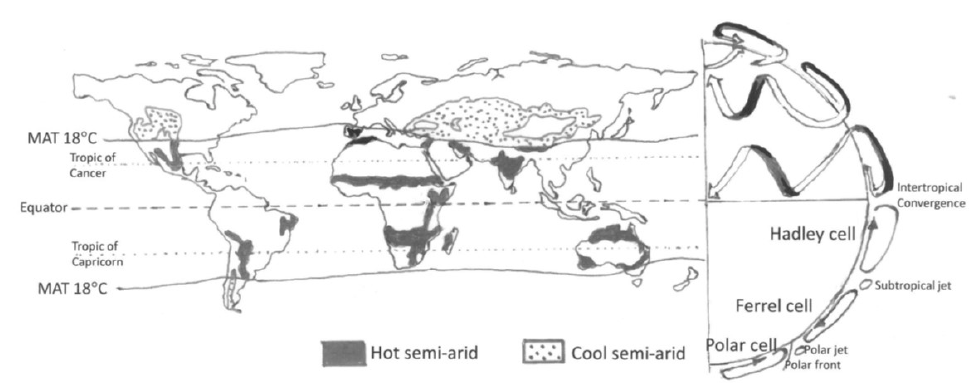
Figure 1. The distribution of semi-arid areas in relationship to the major features of the global atmospheric circulation. The schematic to the right shows in the southern hemisphere a stylised cross section of the globe and the tropospheric cells. The northern hemisphere has a representation of the three-dimensional nature of the circulation, with the surface winds in white and the upper-atmosphere winds in black. The hot semi-arid areas have a mean annual temperature (MAT) above 18 ◦ C and are the main focus of this paper. Cool semi-arid areas share some of their water-limited characteristics, but in addition have a strong control of primary production by low temperatures in winter.